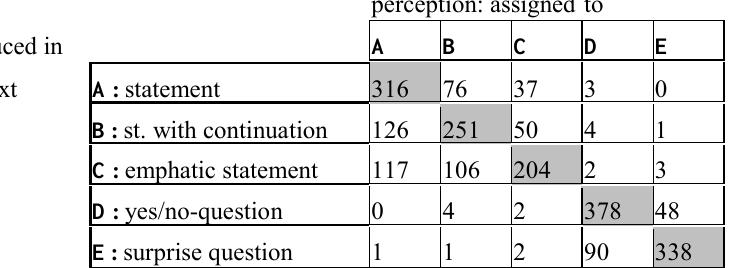
Table 1. Assignments of tokens to categories by the listeners. 'Correct' assignments are highlighted in